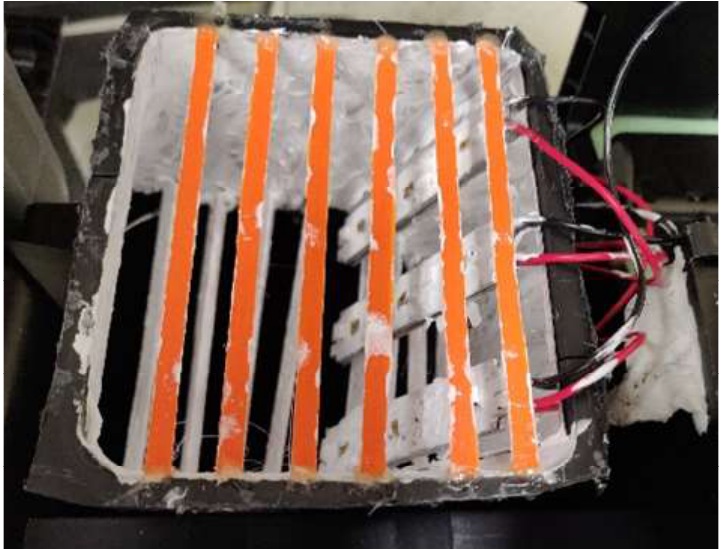
Figure 4. The disinfection chamber as built includes the non-ideality of the BaSO 4 coating, the placement of the triangular extrusion and the extent of the coating of the LED PCB. Between each test and initially, the enclosure was wiped down with 70% ethanol solution and left for more than an hour to decontaminate. An anemometer (BTMeter BT-866A) was used to confirm the air speed of 4.8 m/min such that the flow rate is approximately 250 m 3 /h. The sample pump flow rate through dummy gelatin filters (SKC 225-9551) was measured with a calibrated flow meter (King Instruments 75301112c11) at 24.8 LPM (Liters Per Minute). A solution of 20 mL of bacteriophage Phi6 solution was placed into the nebulizer. The two mixing fans were then run at 8.1 V. The test chamber was then sealed. The humidifier and dehumidifier were then used to adjust the starting humidity to 42% and the temperature was confirmed to be 17.8 ◦ C using HOBO temp/RH logger (Cat #UX100-011A). The humidifier and dehumidifier were then turned off prior to inactivation